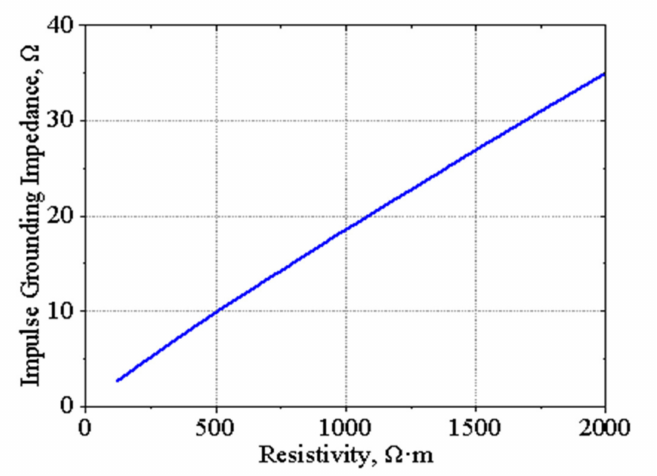
Figure 11. Influence of the soil resistivity on the impulse grounding impedance of a 1 × 1 mesh of 10 m, critical electric field of 10 kV/cm, current peak of 50 kA and 1/200 µ s waveform. The behavior of the impulse grounding impedance as a function of the peak of the injected current is shown in Figure 12. It may be noted that the impulse grounding impedance decreases when the peak of the injected current of the 1 × 1 mesh increases.